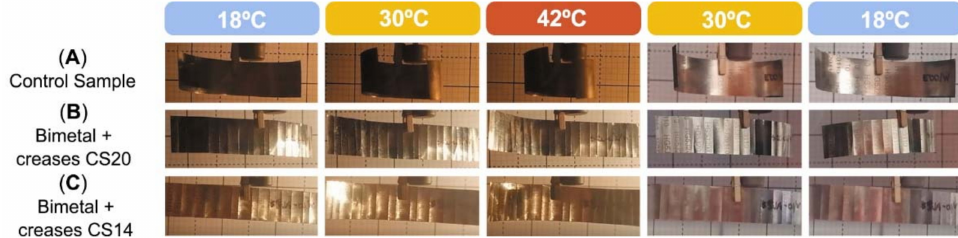
Figure 13. Base experiment: samples submitted to different temperatures ( A – C ). Source: Authors.